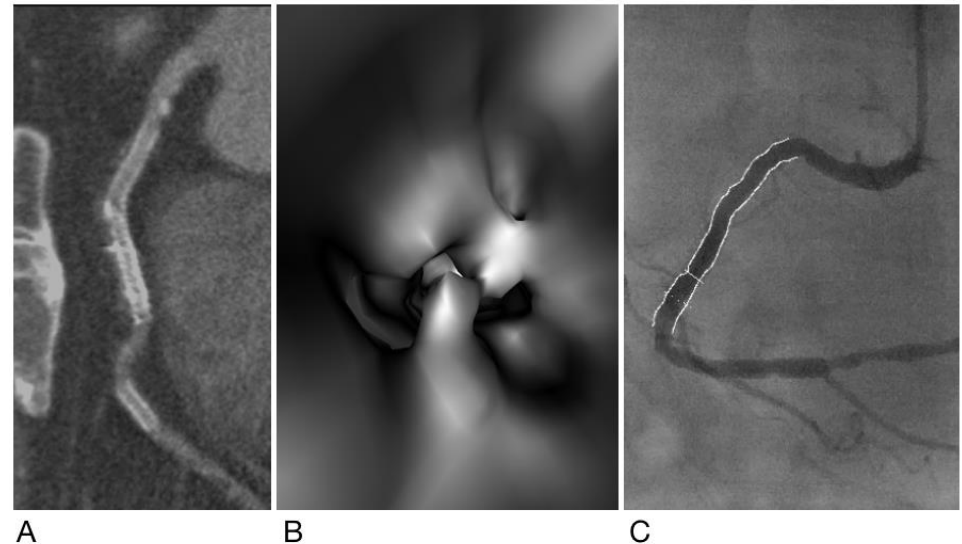
Figure 5. A case of true negative result for CCTA but false positive result for VIE. Subject is a 72-year-old man with hypertension and with 3 metallic stents placed in the right coronary artery. CCTA ( A ) showed intimal hyperplasia in all three stents without ISR, but VIE ( B ) found ISR in the middle stent. ICA ( C ) showed only intimal hyperplasia with 34% stenosis in the middle stent.